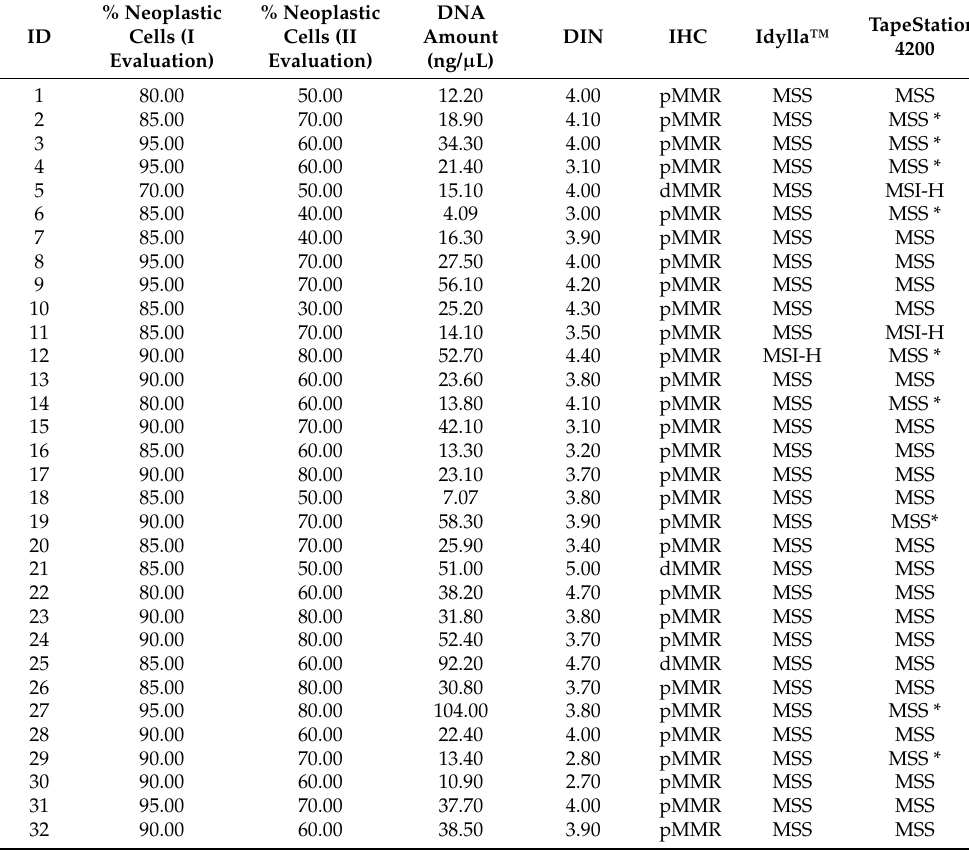
Table 4. Summary of molecular analysis of MMR/MSS status for prostate cancer